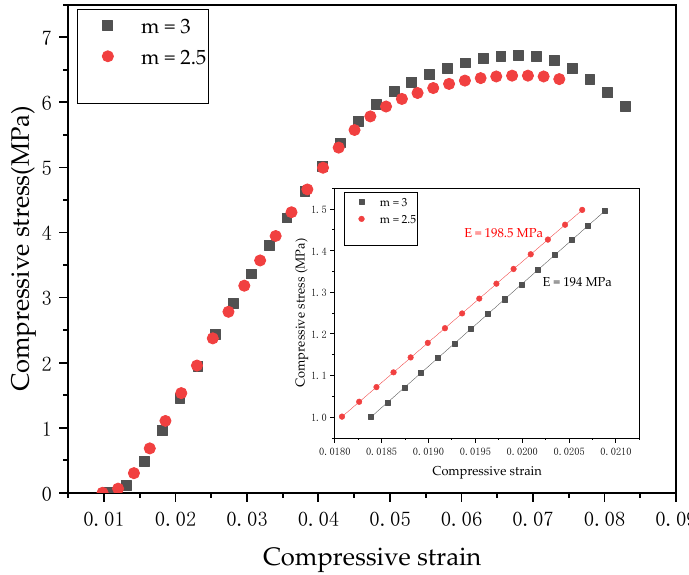
Figure 11. The stress and strain curve of the uniaxial compression test.